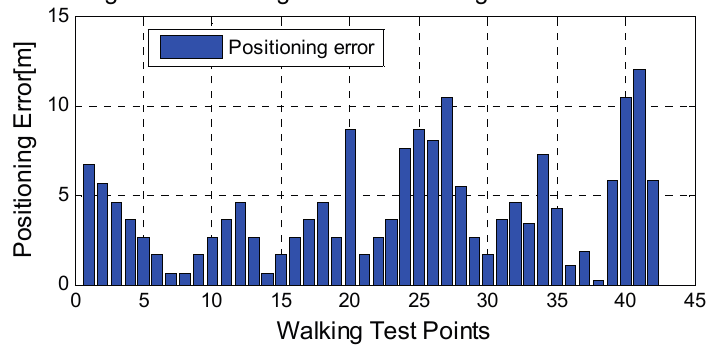
Figure 6. Walking Test positioning errors on Floor 12 with the proposed Radio